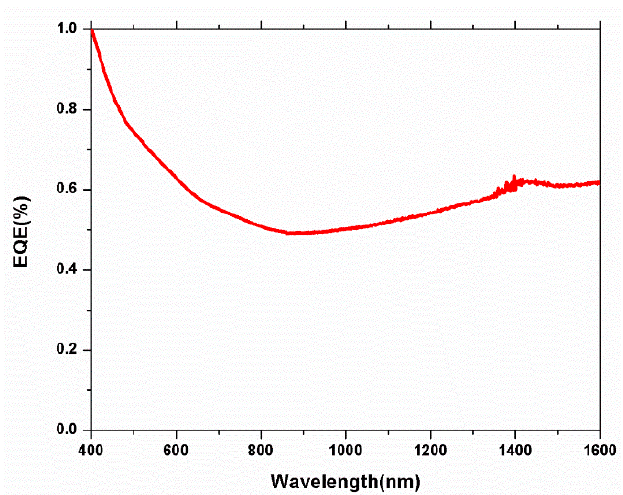
Figure 9. The external quantum efficiency (EQE) of our fabricated spin-coated device.